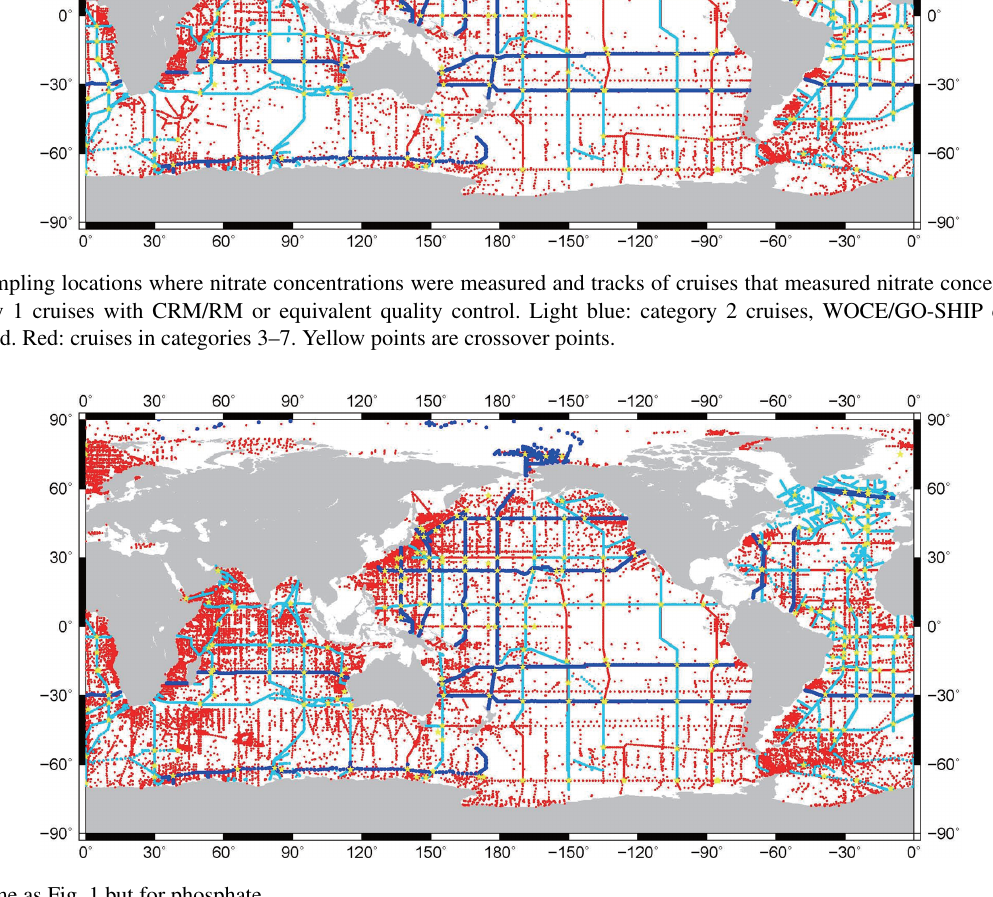
Figure 2. Same as Fig. 1 but for